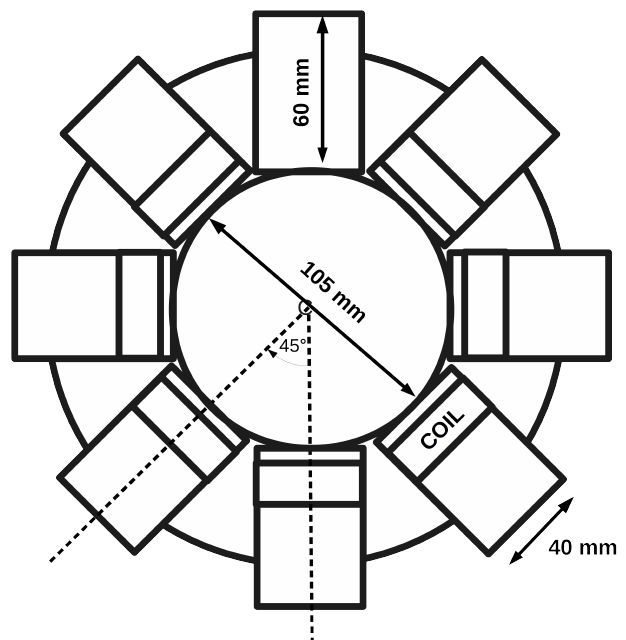
Figure 1. Diagram of array, indicating coil position and dimensions.